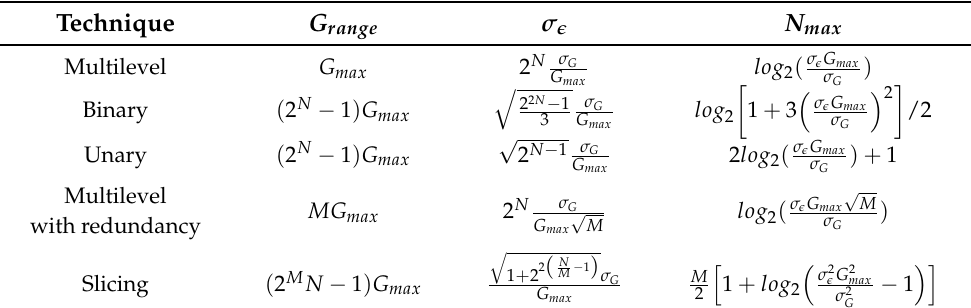
Table 1. Comparison of various mapping schemes, in terms of conductance range, variability-induced error and resulting maximum number of programmable bits.